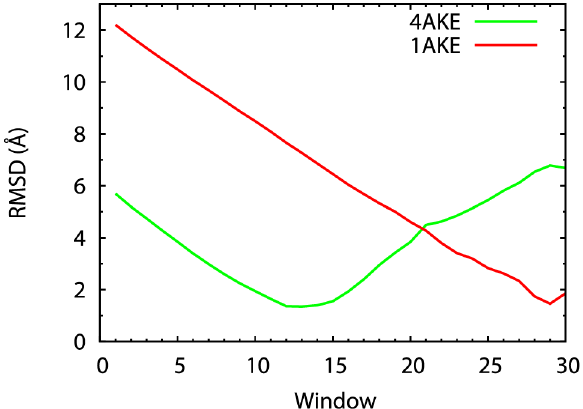
Figure 5. A comparison of the average conformations from the umbrella-sampling simulations to the crystal structures. Aver- age C a coordinates for each of the 30 umbrella windows were calculated from the trajectories. The RMSDs between these average C a coordinates and the two crystal structures are plotted in the figure.